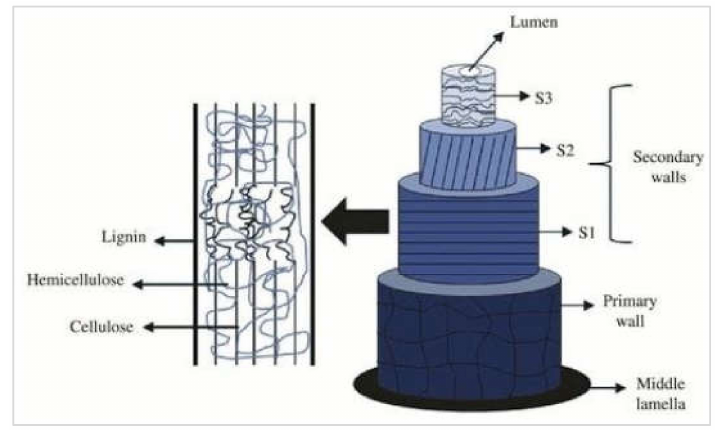
Figure 8. Structure of a plant fiber [120].